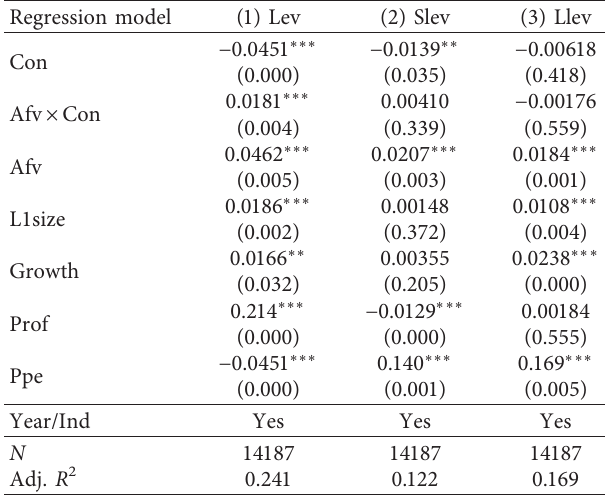
Table 4: Fixed effect regression of fair value, manager overcon- fidence, and debt ratio.